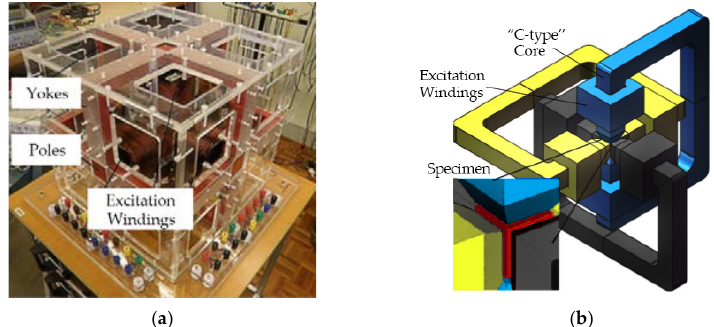
Figure 1. Experimental platform: ( a ) Main measuring system; ( b ) Diagrammatic sketch of magnetic circuit for measurement. The measuring system was used to get the 2-D magnetic properties of the material. During the experiment, a cubic specimen made of SMC with a size of 22 × 22 × 22 mm 3 was fixed in a sensing box mounted with B - H sensing coils on six sides to measure the corresponding B and H .